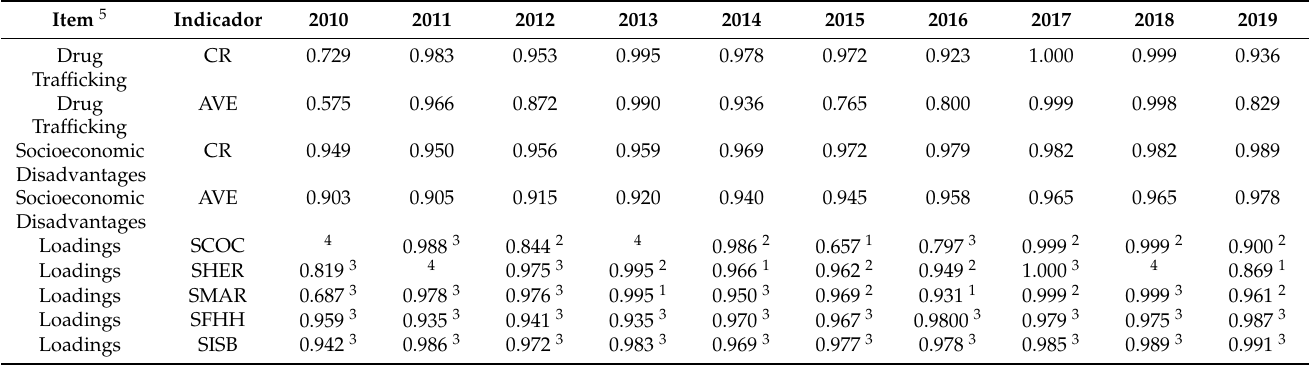
Table 4. Measurement Model